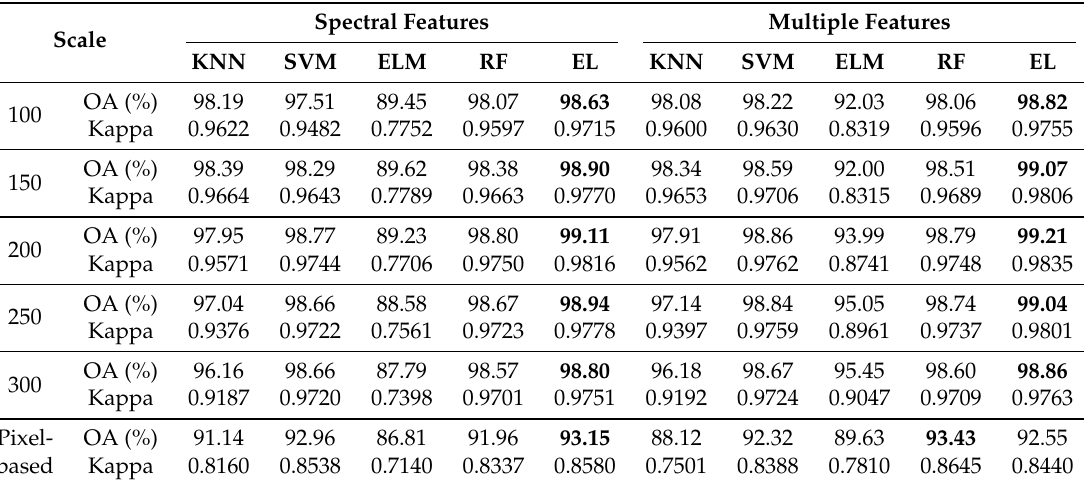
Table 2. Overall accuracies of change detection and Kappa coefficients of Experiment A for different segmentation scales and feature selection strategies.